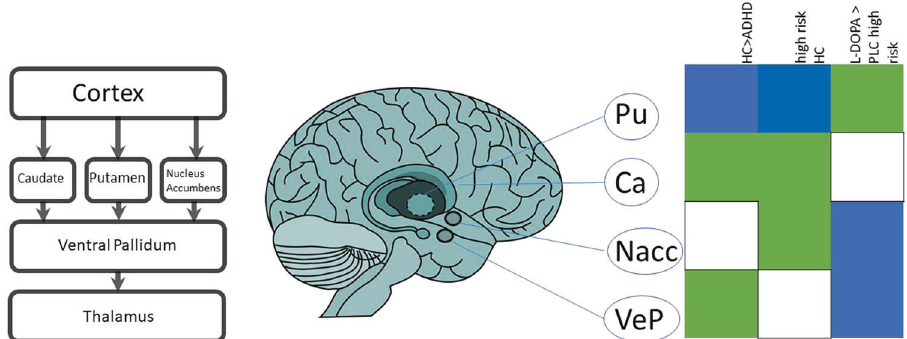
Fig. 3 Overview results: direction of connectivity for the speci fi c seed region-of-interest. On the left, a modi fi ed overview of the neuronal signal fl ow from the cortex to the thalamus (and back) gives an impression where in the loop our speci fi c ROI masks are situated. In addition to the well-known motor loop, putamen and caudate are part of an associative and executive loop, whereas the nucleus accumbens is part of the limbic loop. The ventral pallidum is downstream in this loop. The thalamus projects back to the cortex, thus forming a loop (not shown) apart from their motor function. In the middle, a stylized sagittal view gives an impression of neuroanatomical localization. On the right, the matrix gives an abstract overview of the aforementioned results. Green codes a positive direction of the ROI on the left, blue a negative correlation. Each column gives directionality for ADHD > HC, the placebo condition in high-risk participants and in the comparison L- DOPA > placebo in high-risk participants. The main fi nding. Putamen-derived connectivity shows a directionality switch from the DAN during L-DOPA